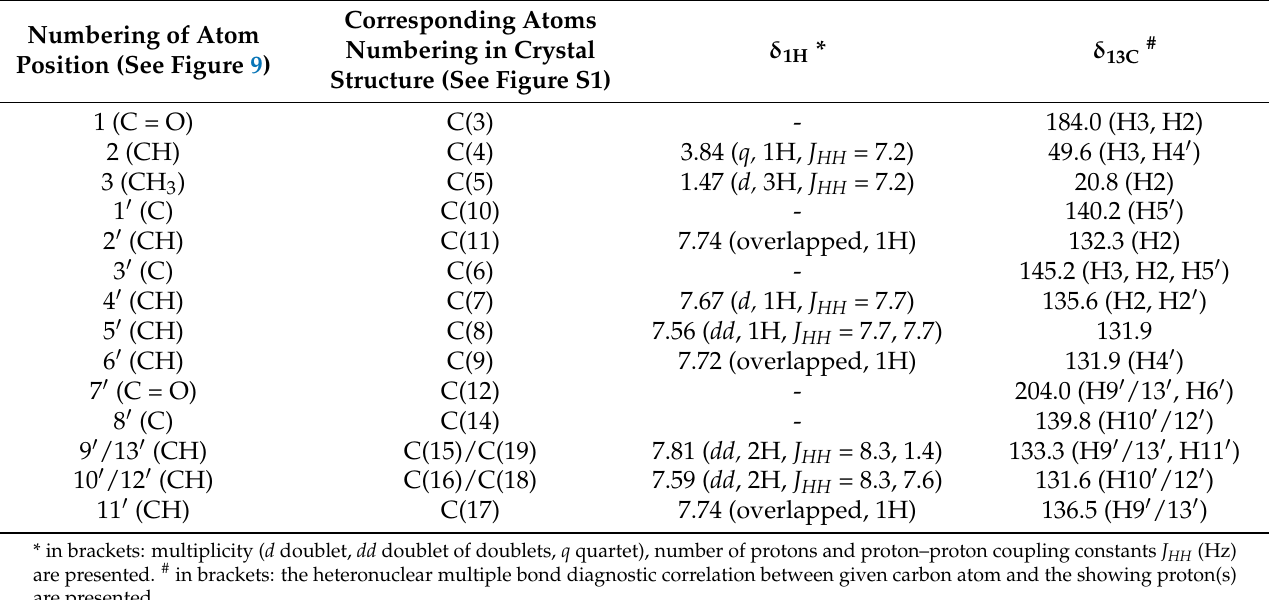
Table 2. The experimental 1 H and 13 C NMR chemical shifts δ (ppm) for racemic ketoprofen (KP) in D 2 O, C = 0.5 mM, pH 4.6, temperature of 25 ◦ C.